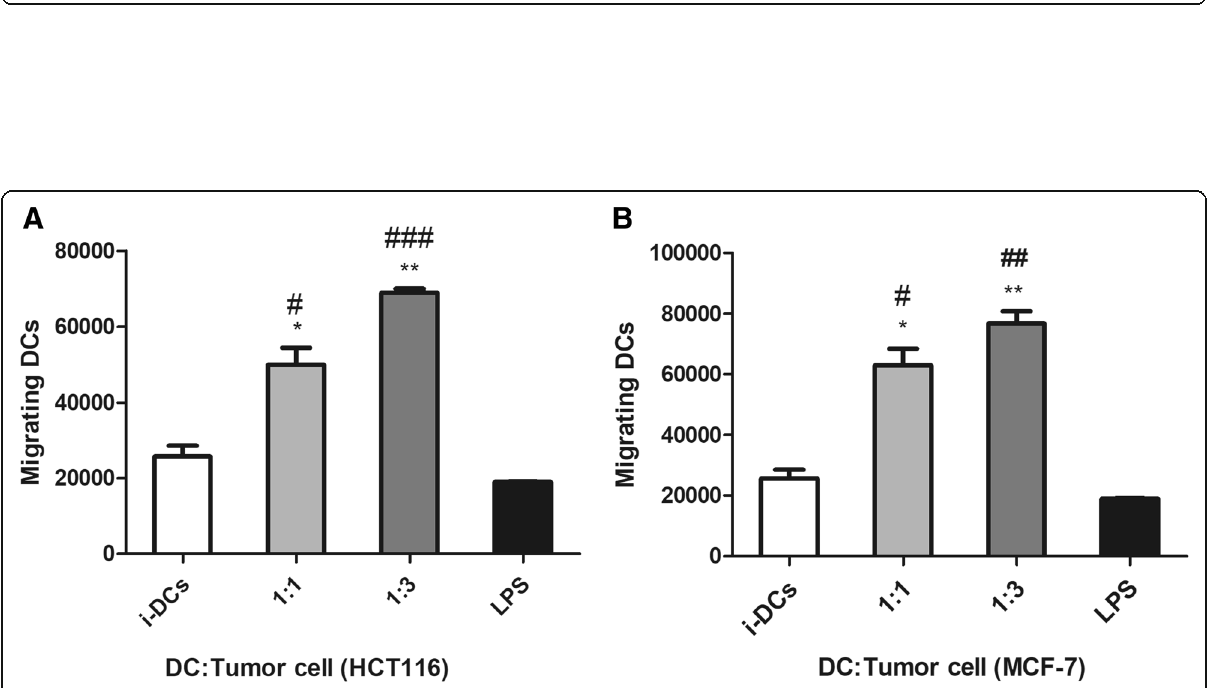
Fig. 6 Enhancement in the migration capacity of tumor lysate pulsed dendritic cells. * P <0.05, ** P <0.01 and *** P <0.001 for a HCT-116-TLY-DCs and b MCF-7-TLY treated DCs versus iDCs. # Indicated significant difference (# P <0.05, ## P <0.01 and ### P <0.001) of TLY-DCs versus LPS-stimulated DCs. Data were statistically analyzed by one-way ANOVA followed by post Dunnett ’ s test. Each point represents the mean±SEM of three experiments comprising three different healthy donors. iDCs, immature dendritic cells; TLY, tumor lysate; LPS,